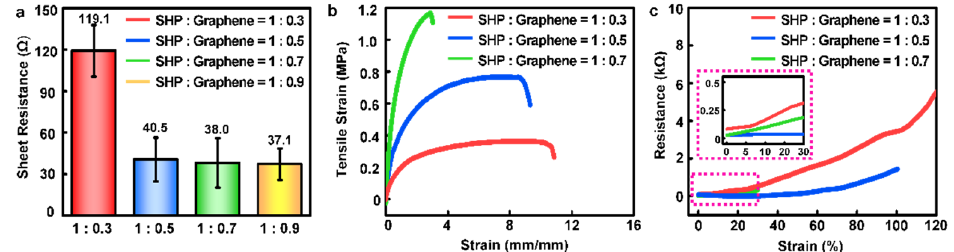
Figure 2. Electrical and mechanical characterizations of a stretchable conductive composite. ( a ) Sheet resistance, ( b ) stress–strain curve, and ( c ) changes in strain-dependent resistance of SHP–graphene composites with different weight ratios of graphene.